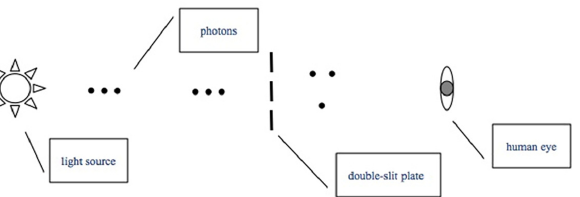
Fig 6. Simplified experimental procedure model. Photons are individually emitted by the source. They pass a double-slit assembly and reach the eye.